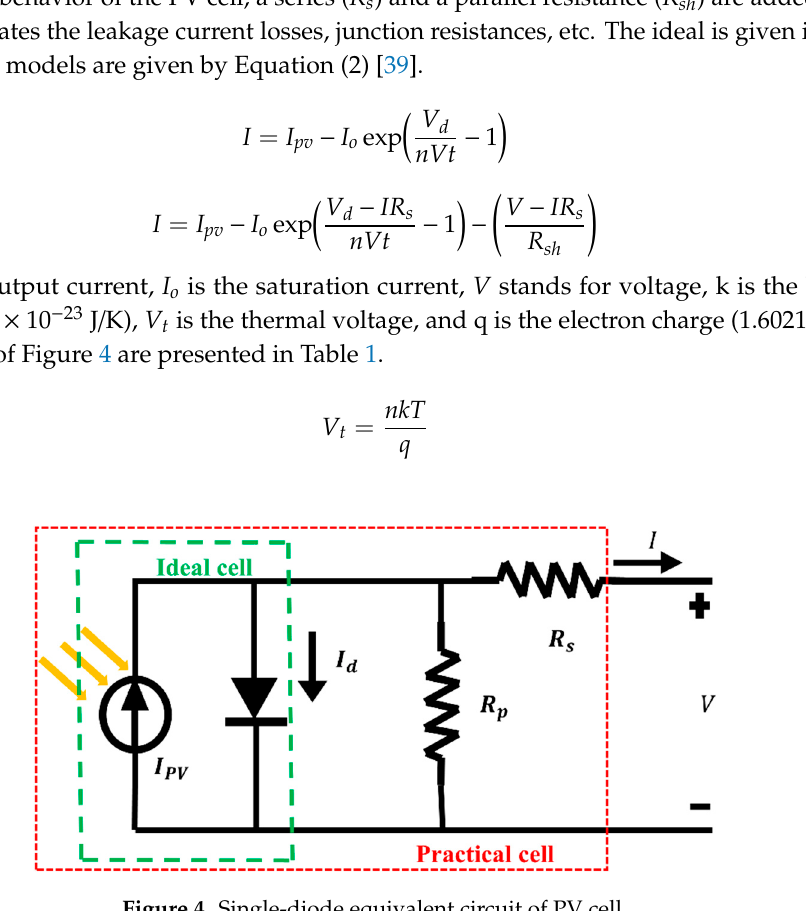
Figure 4. Single-diode equivalent circuit of PV cell. Table 1. Symbols of PV cell nomenclature.